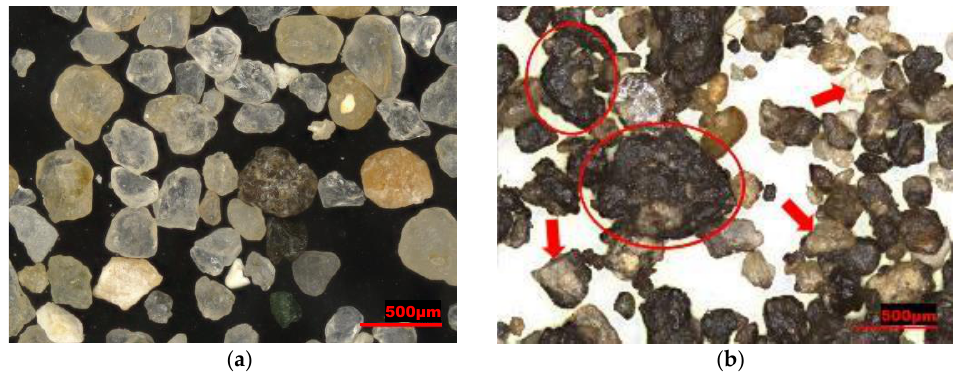
Figure 12. Fine aggregates ( a ) natural ( b ) RAP.